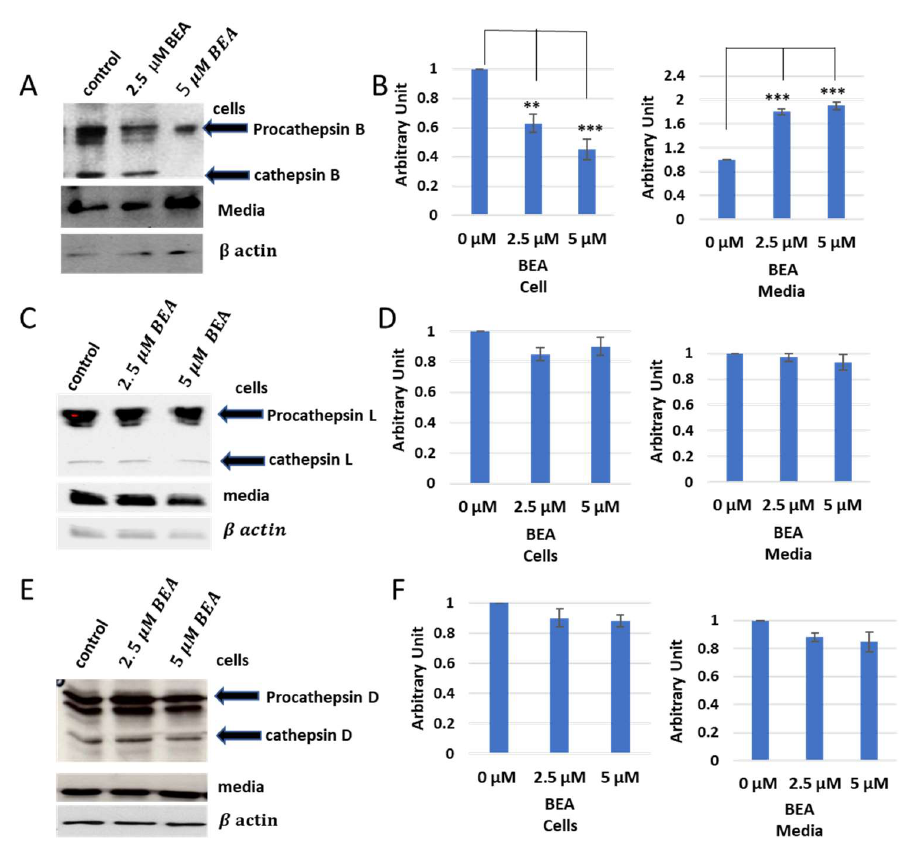
Figure 8. Secretion levels of cathepsin B, cathepsin D, and cathepsin L after treatment with different concentrations of BEA. ( A ) Western blot analysis of cathepsin D in cells and media. ( B ) Evaluation of cathepsin B contents in cells and media. ( C ) Cellular and media contents of cathepsin D. ( D ) Evaluation of cathepsin D in cells and media. ( E ) Cellular and media contents of cathepsin L. ( F ) Evaluation of cathepsin L contents in cells and media. The data were analyzed using one-way ANOVA with Bonferroni’s and Dunnett’s post hoc analysis (** p < 0.01; *** p < 0.001; N = 7). Statistics were calculated using GraphPad Prism.